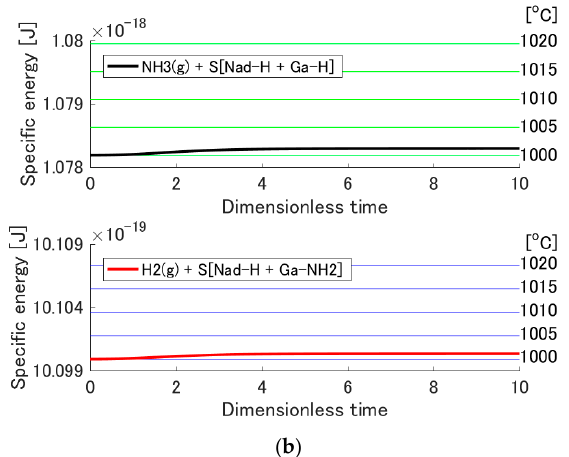
Figure 5. Evolution of the specific energy of each subsystem as a function of the dimensionless time for the adsorption reactions on ( a ) S[3Ga-H] and ( b ) S[N ad -H + Ga-H]. Green and blue horizontal lines correspond going from bottom to top to the specific energies at 1000, 1005, 1010, 1015, 1020 °C.